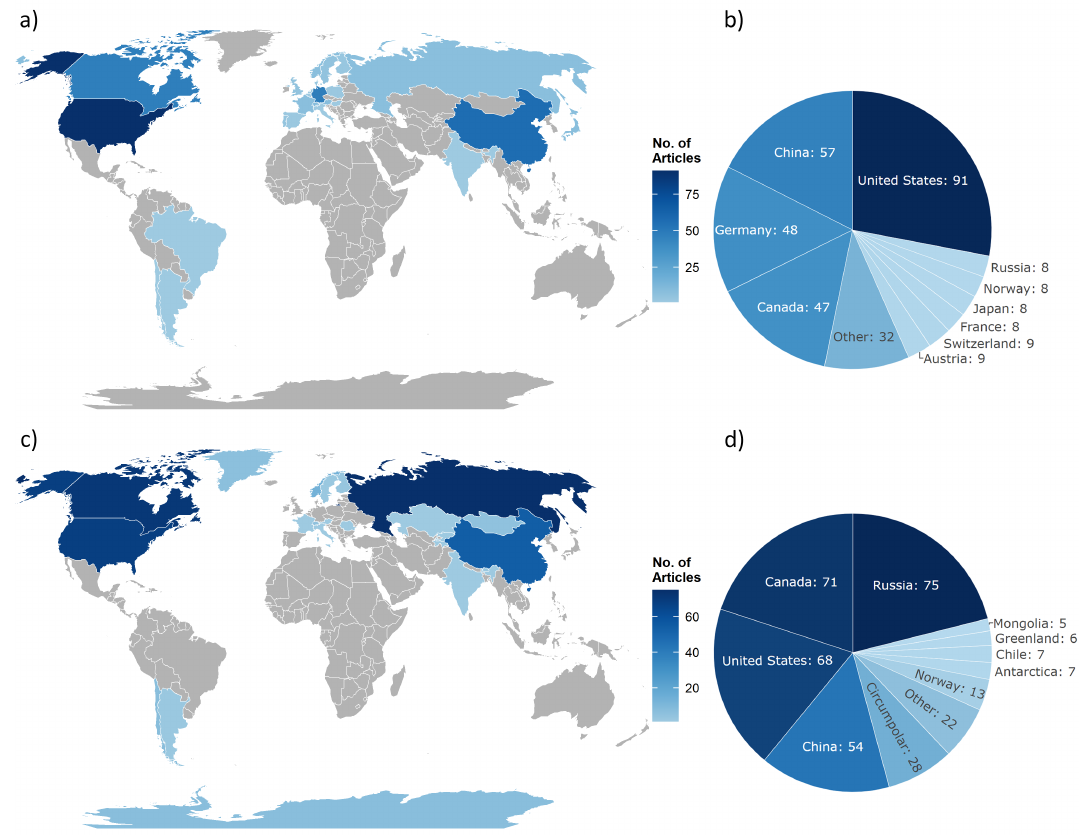
Figure 4. Map showing the frequency of first author institution nationalities ( a ) and the relative distribution ( b ). Next to the first author institution, the frequency of study countries are displayed via a map ( c ) and the relative distribution as a pie chart ( d ). Circumpolar studies are hereby excluded from the map ( c ). Some articles featured study areas in multiple